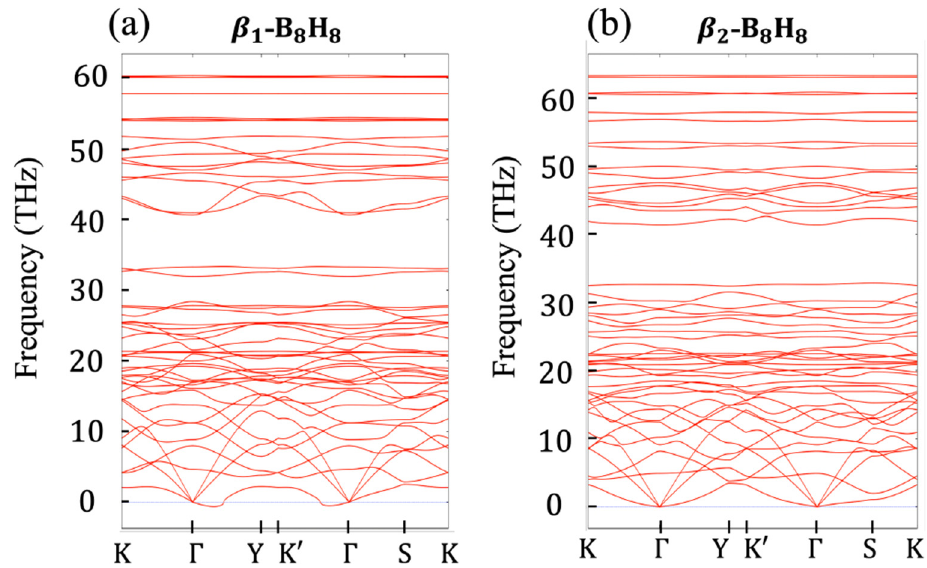
Figure A3. Phonon dispersion diagrams of the ( a ) β 1 - and ( b ) β 2 -borophane. The letters shown in (a) and (b) represent the high symmetry points in the first Brillouin zone shown as insets of FigureA2b and Figure A2f.